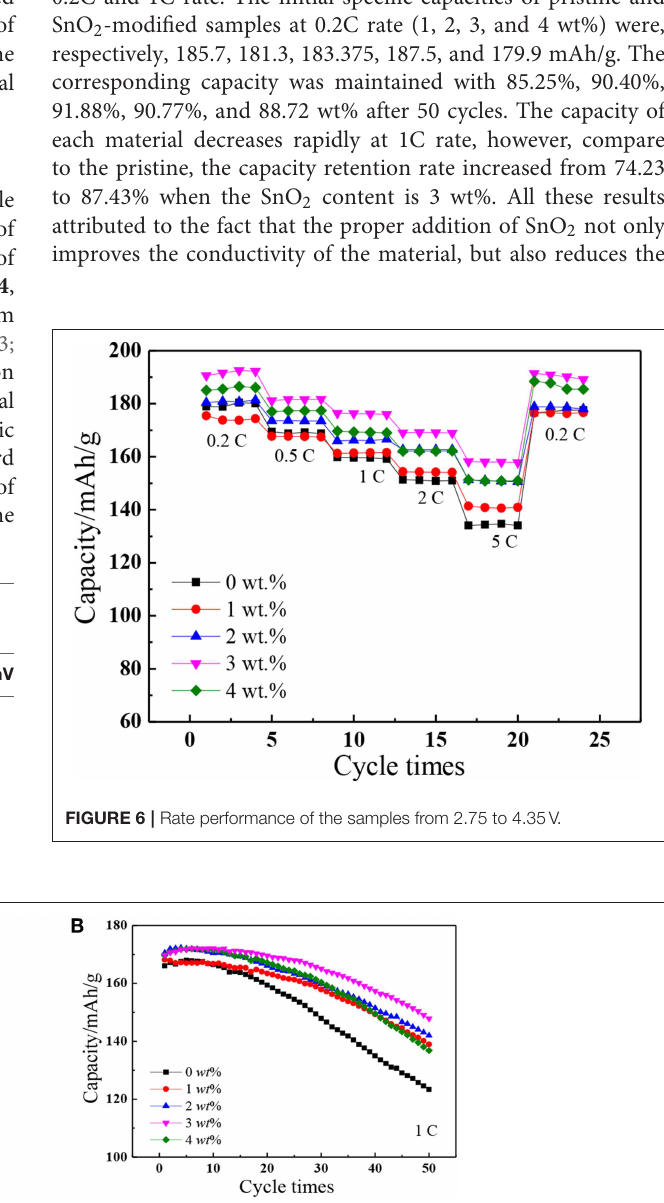
FIGURE 5 | Cyclic performance of all samples at 0.2C rate (A) or 1C rate (B) .